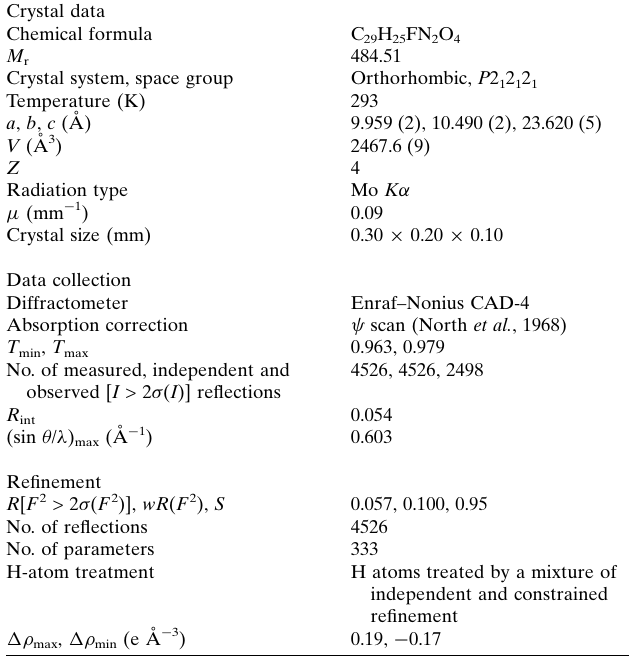
Table 2 Experimental details.